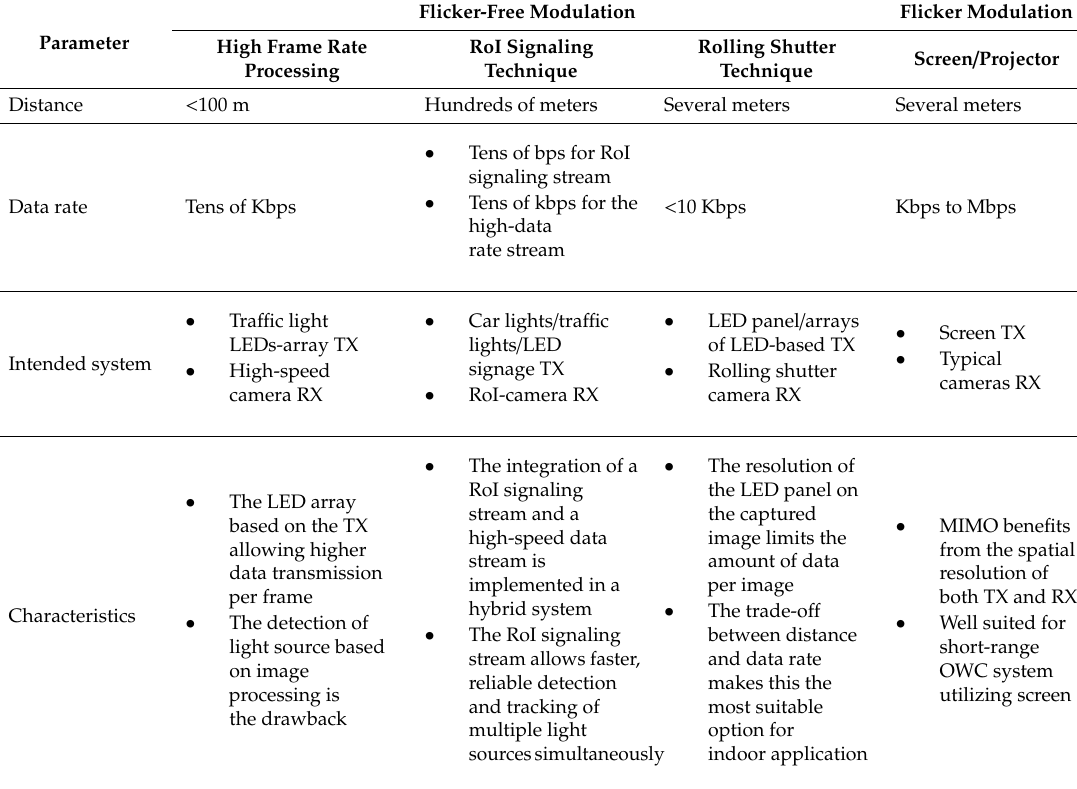
Table 2. IEEE 802.15.7m: Characteristics and performance estimation of OCC